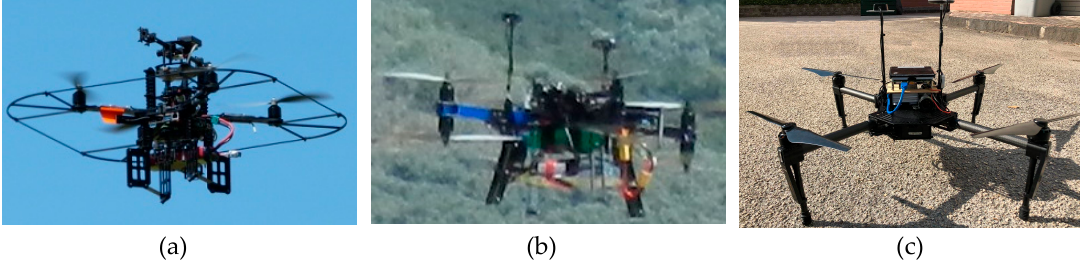
Figure 10. UAVs exploited for the flight test campaign. ( a ) Tracker UAV for database A: customized Pelican by Ascending Technologies. ( b ) Target UAV for database A: customized X8 + by 3D Robotics. ( c ) Target and tracker UAV for database B: customized M100 by DJI.